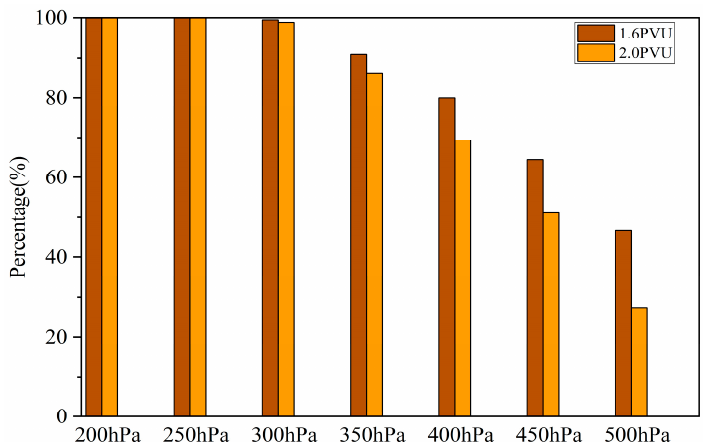
Figure 2. Percentage of COLs in which 1.6 or 2.0 PVU isoline dips below the barometric surfaces of the 200, 250, 300, 350, 400, 450, and 500 hPa, respectively.